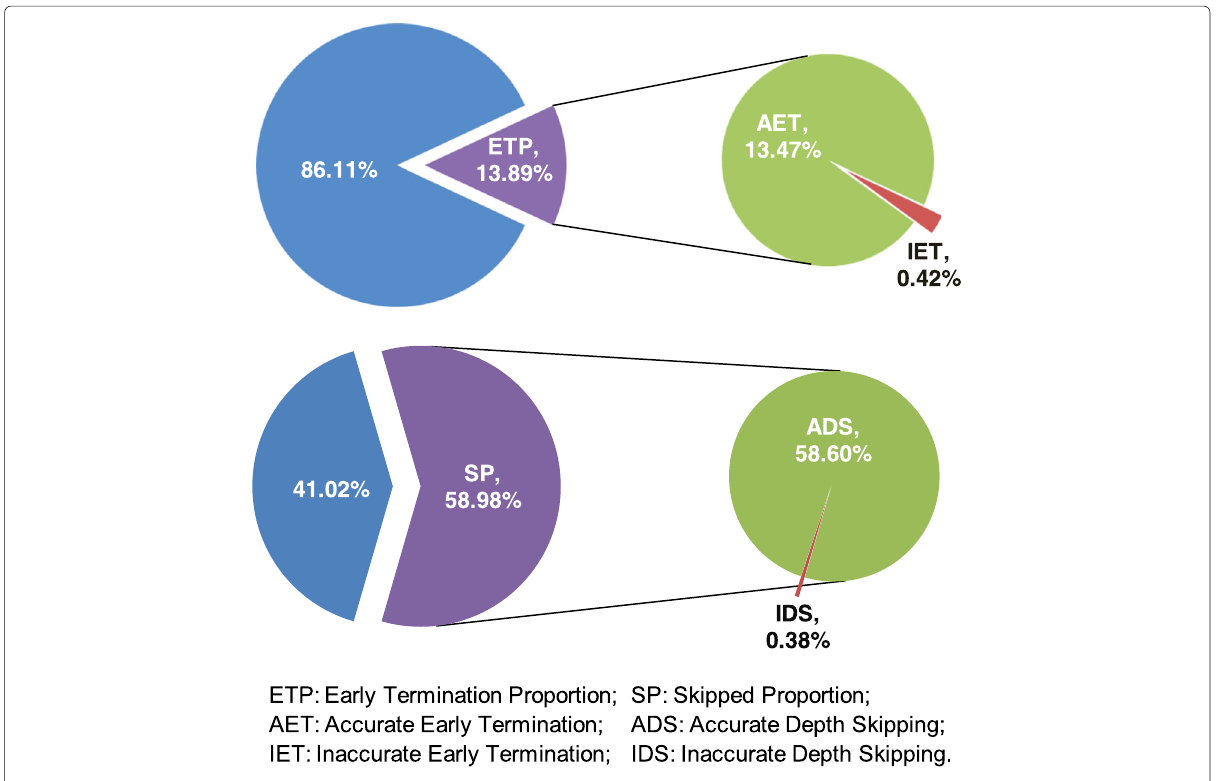
Fig. 5 Fast decision proportion and the corresponding coding